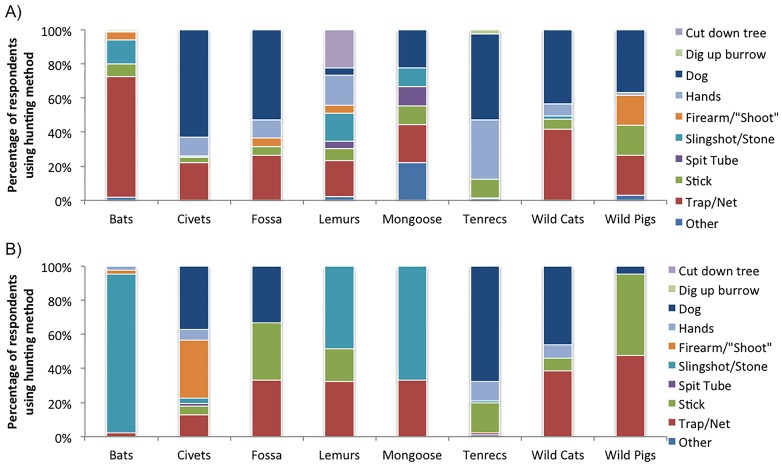
Hunting methods used to capture wild mammals by urban (1A) and rural (1B) respondents (percentages).Individuals are replicates; data taken from meat consumption interviews. Hands = catching with hands by one or multiple people. Trap/Net = includes nets, cable traps, bait with traps. Spit Tube = a blow tube or a device to shoot darts. Stick = includes hitting animal with stick or spearing animal with stick. Individuals are replicates. Other = includes other hunting methods (e.g. fire, using a cross bow).